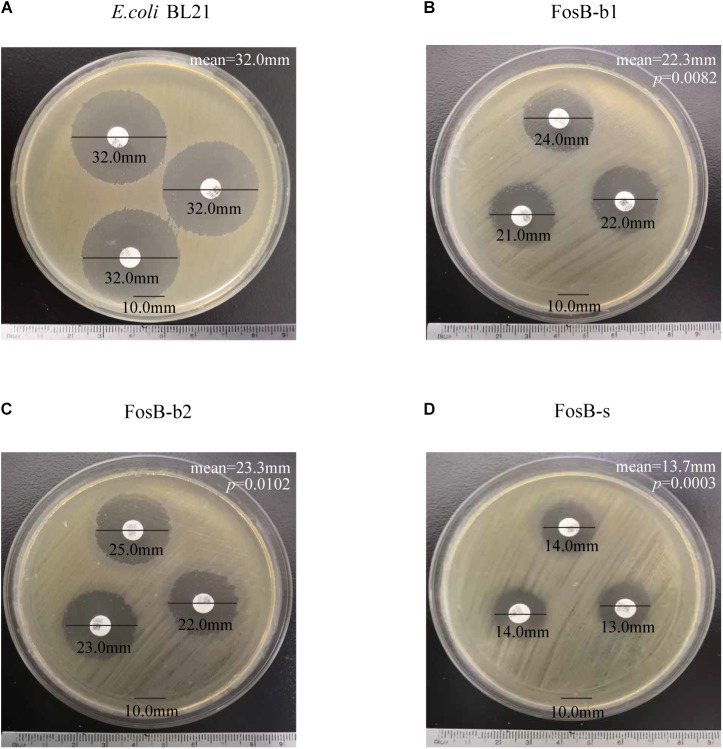
Kirby-Bauer susceptibility testing of (A)
E. coli BL21, (B) FosB-b1, (C) FosB-b2 and (D) FosB-s. p values were calculated by student’s T-test, p < 0.05 was considered as statistically significant, versus the diameter of inhibition zone of E. coli BL21.